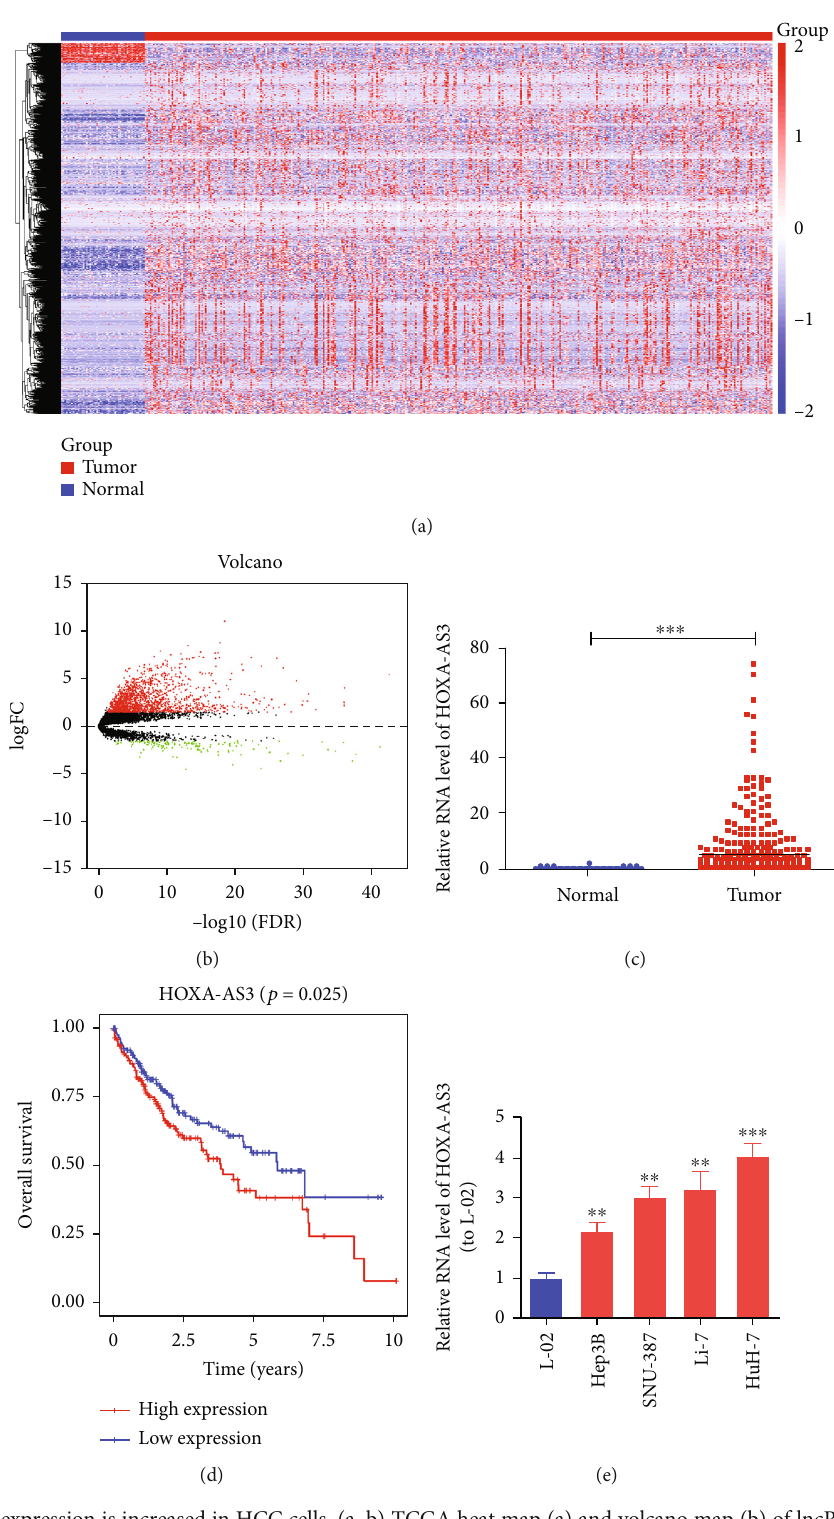
Figure 1: HOXA-AS3 expression is increased in HCC cells. (a, b) TCGA heat map (a) and volcano map (b) of lncRNA expression in HCC patients. (c) HOXA-AS3 expression in HCC tissues and controls in TCGA dataset. (d) Association of high HOXA-AS3 expression with shorter overall survival in TCGA dataset. (e) HOXA-AS3 expression in HCC cell lines. Data are reported as the mean ± SD of three separate experiments; ∗∗ P < 0 : 01 and ∗∗∗ P < 0 : 001